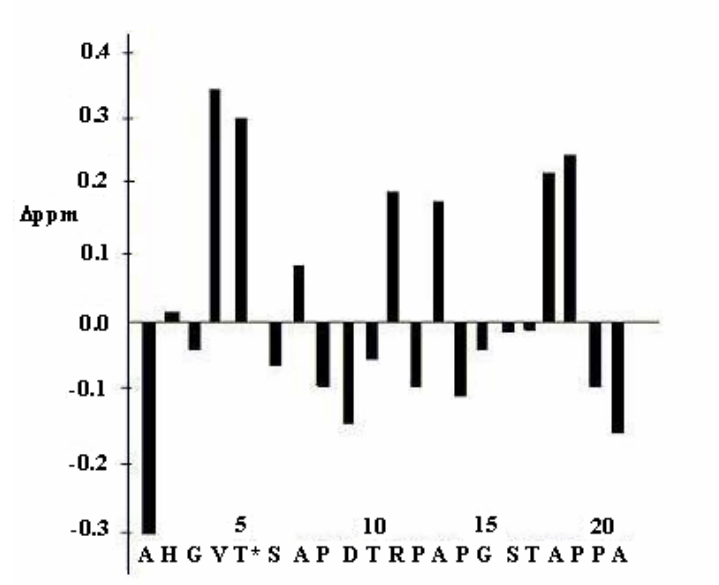
Figure 3. α H chemical shift deviations of amino acid residues in the glycopeptide from their corresponding random coil values ( * = α -Glc-1,4- β -Glc-1,4- α -GalNAc- ).